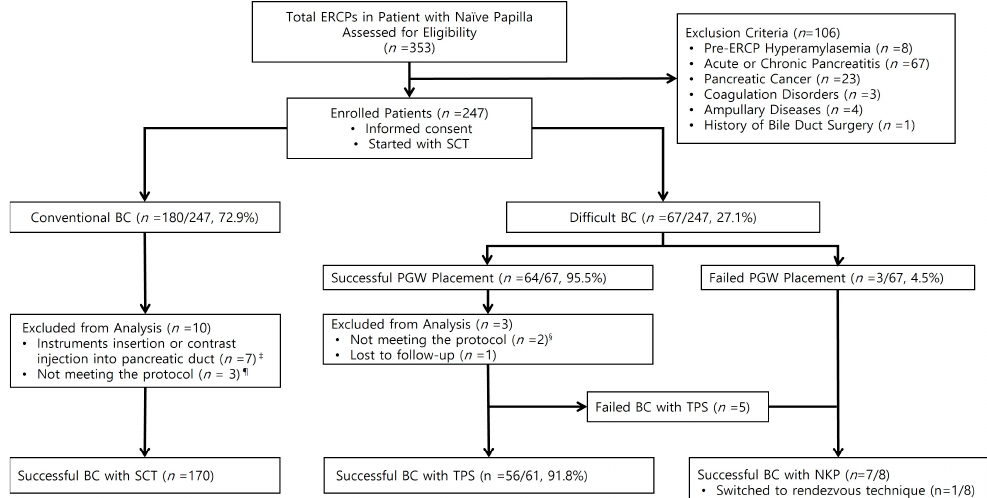
Figure 1. The selection of participants in the study. Legend . ERCP : endoscopic retrograde cholangiopancreatography, SCT : standard cannulation technique, BC: Biliary Cannulation, PGW: Pancreatic Duct Guidewire, TPS : transpancreatic precut sphincterotomy, NKP : needle-knife precut. ‡ Intentional or unintentional insertion of the instruments or contrast injection into the pancreatic duct. ¶,§ Protocol violence. The endoscopic removal of prophylactic pancreatic stent was performed during the 2nd ERCP session which occurred within 2 days.